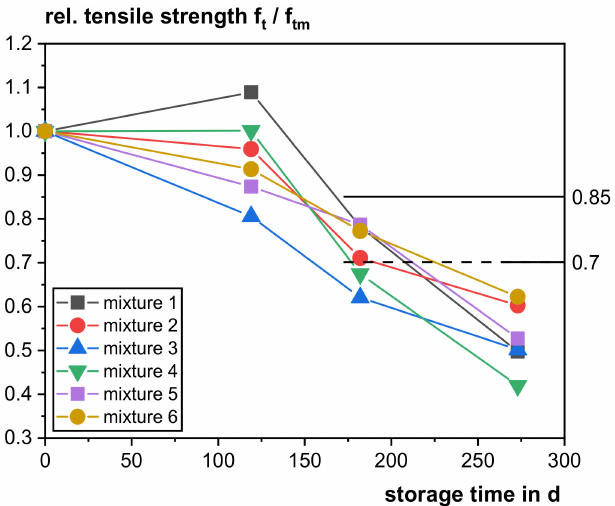
Figure 10. Relative tensile strength f t /f tm of six identic concrete mixtures with (2) CEM I 42.5 N after 119, 182 and 273